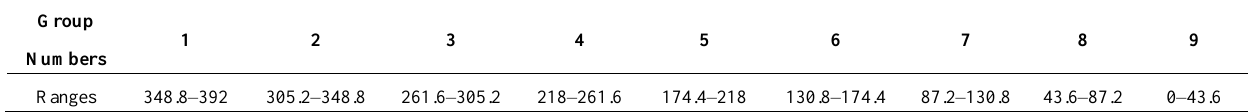
Table 7. The divided groups of total